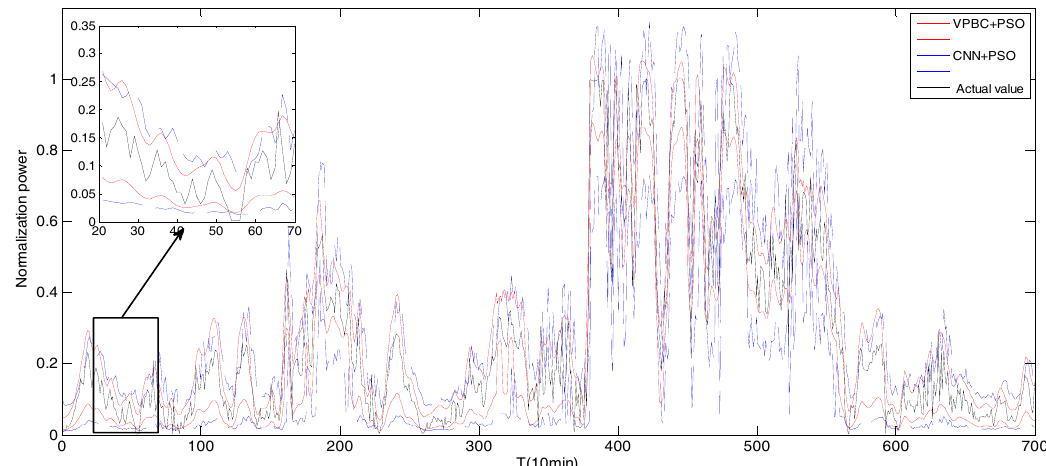
Figure 7. Forecasting results of the VPBC + PSO and CNN + PSO methods at 80% PINC.